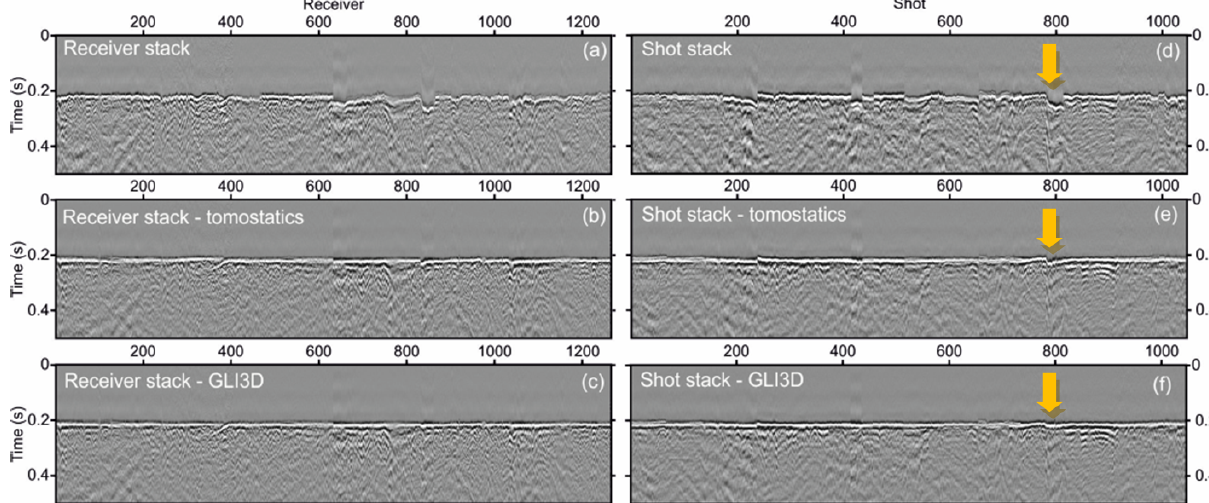
Figure 5. (a–c) Common-receiver and (d–f) common-shot stacks calculated for the data after a simple linear-moveout (LMO) correction and with the application of the tomostatics (b–e) and GLI3D statics (c–f) .